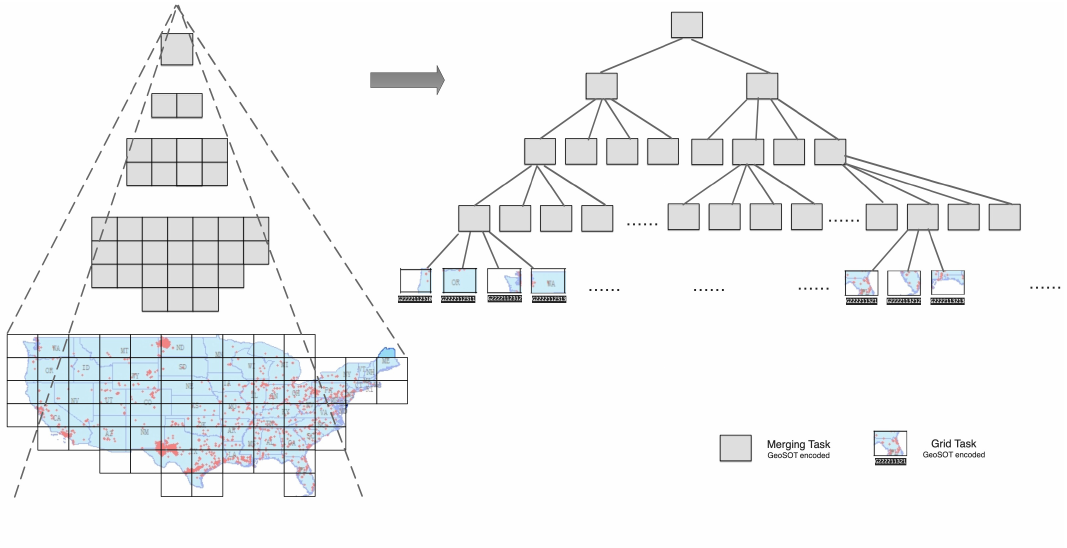
Figure 6. Building a GeoSOT-encoded quad task-tree from millions of fire